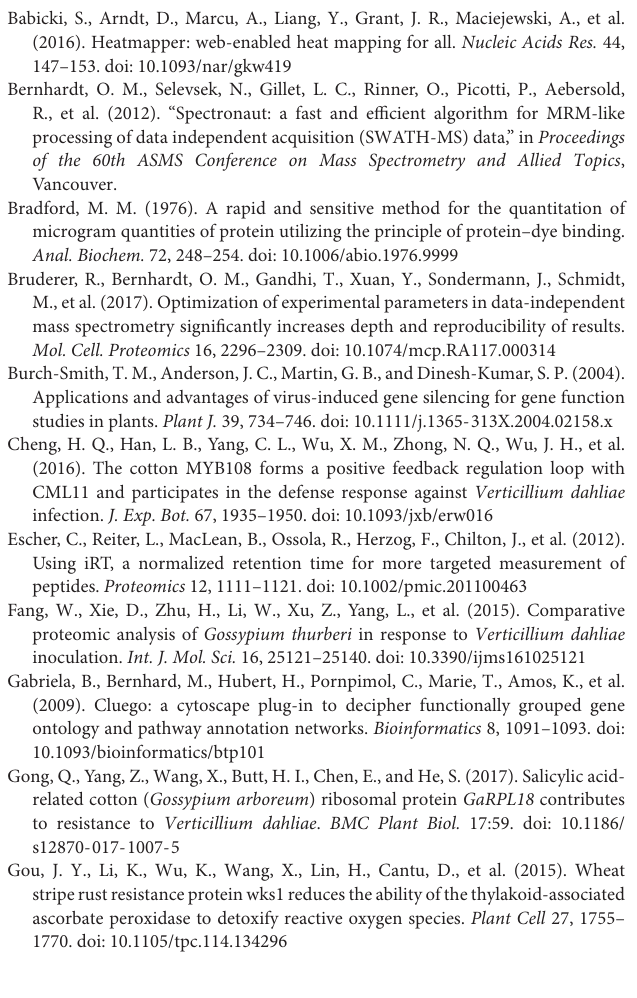
Supplementary Figure 12 | Phenotypes and qPCR assays of the positive control. TRV: GbCLA was used as a positive control for VIGS. Silencing of GbCLA